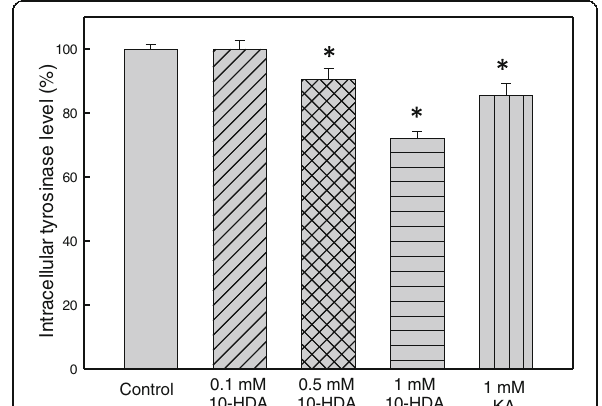
Fig. 1 Effect of 10-HDA on B16F10 melanoma cell viability. a – c Different letters among samples indicate significant differences ( P < 0.05)